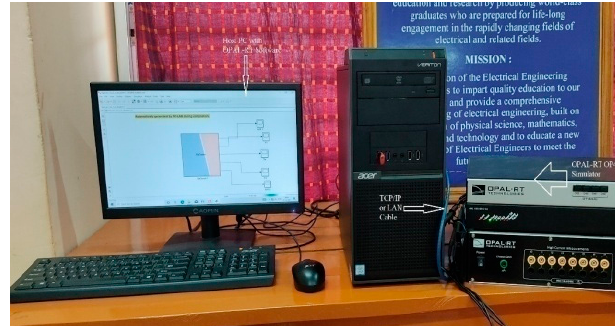
Figure 25. OPAL-RT test bench.